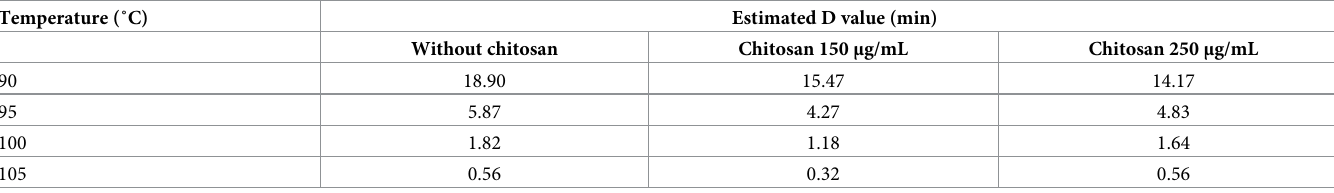
Table 1. Estimation of thermal resistance parameters by a nonlinear regression in the different substrates. Temperature